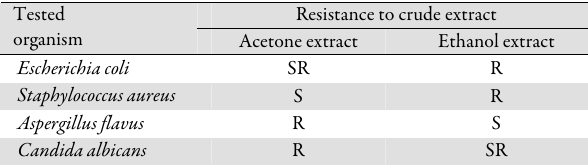
Table 3. Antibiotic activity results of H. involuta extracts